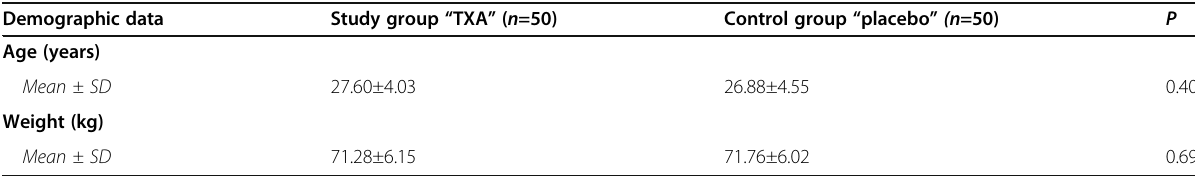
Table 1 Personal characteristics Demographic data